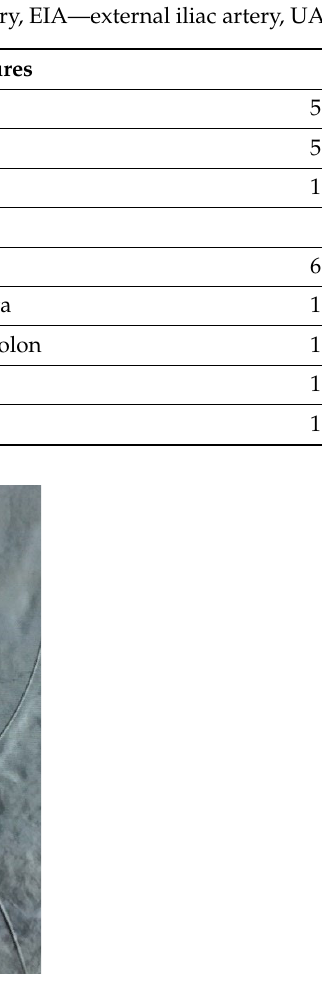
Figure 1. Arteriographic aspect of complex fistula between left ureter, left external iliac artery and descending colon. descending colon. Table 2. Pretreatment diagnostic imaging sensitivity and location of UAF fistula (CT—computed